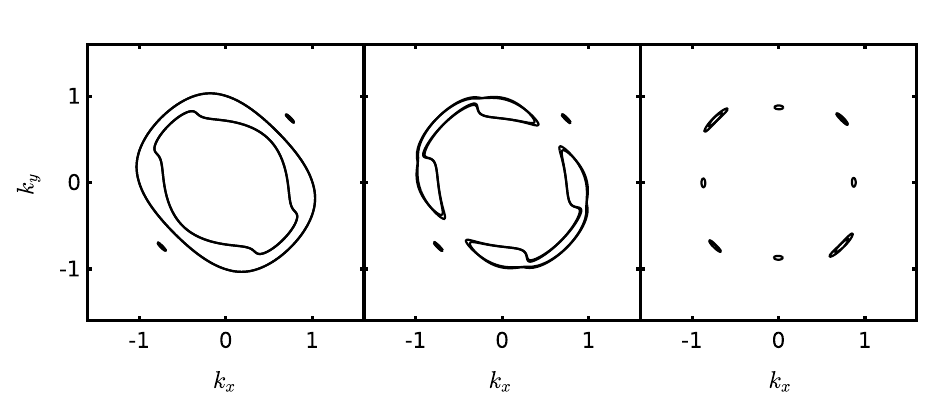
Figure 3. Fermi surface topology of the three-orbital model 20 , whose notation refers to the two-iron unit cell. The wave vectors Q 1 = ( ± π , π) and Q 2 = ( − π ± δ , π ± δ) refer to the commensurate SDW ordering wavevector of the host Fe-system and to the incommensurate order induced by the Mn impurities, respectively. G , M X , and M Y denote the corresponding points of the BZ. Note that the outer hole pocket shows a stronger nesting with the electron pockets than the inner one.